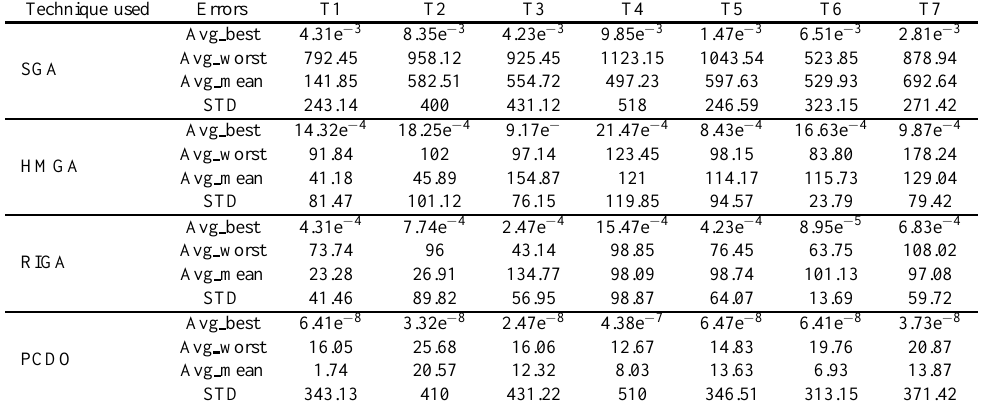
Table 3. Error Values Achieved for Problems F 3 .